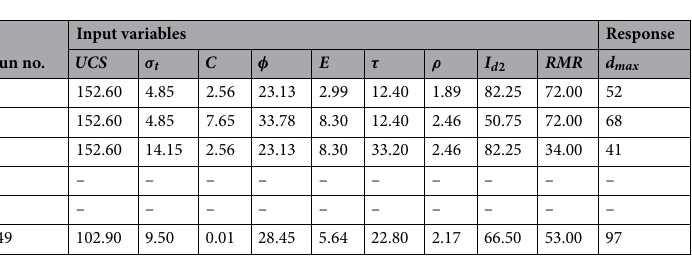
Table 3. Part of CCD consisting of nine experimental factors and numerical results.